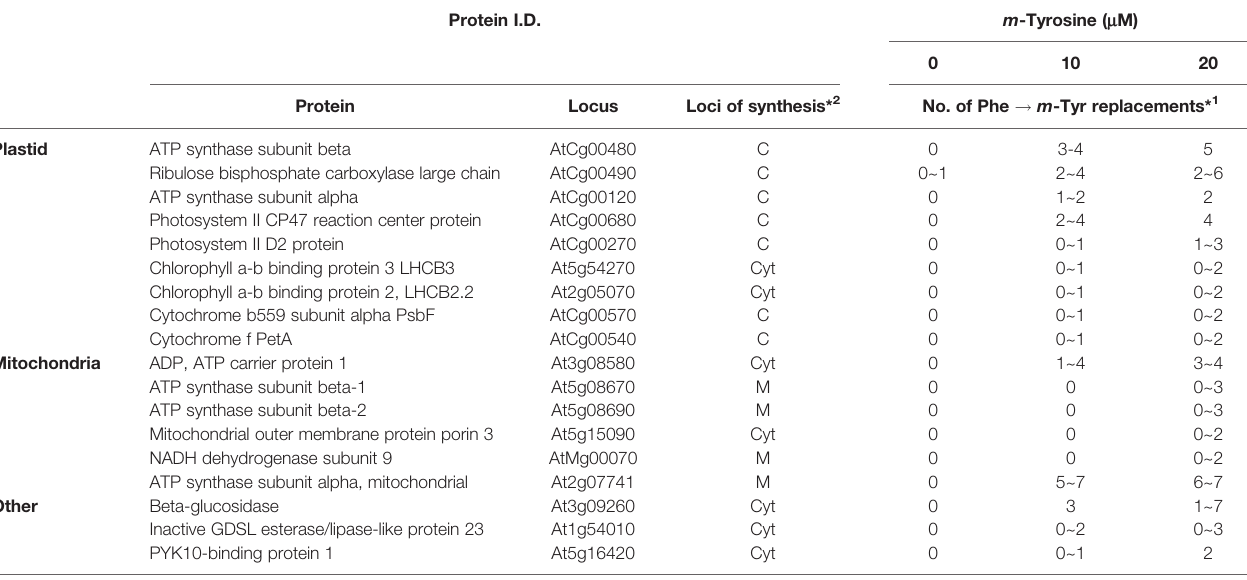
TABLE 3 | Summary of four independent proteome analyses of enriched organellar fractions obtained from 5-day-old seedlings grown in the absence or presence of m -tyrosine. Protein